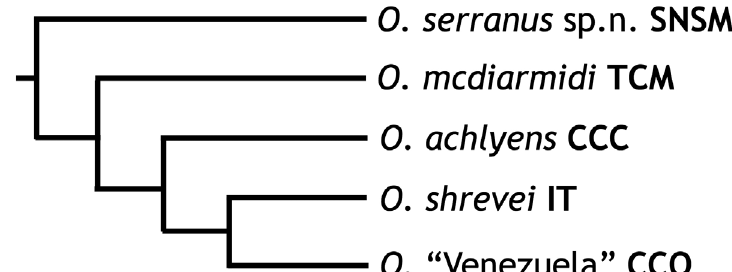
Figure 6. Summary of the phylogeny and geographic distribution of Oreosaurus (Sánchez-Pacheco et al. 2017). SNSM = Sierra Nevada de Santa Marta, Colombia; TCM = tepuis from the Chimantá massif, Venezuela; CCC = Cordillera de la Costa Central, Venezuela; IT = island of Trinidad; CCO = Cordillera de la Costa Oriental, Venezuela. Oreosaurus luctuosus , from the CCC, and O. rhodogaster , from the CCO, were included in this genus due to the presumed close relationships of these species and O. achlyens and O. shrevei , respectively. Data taken from Sánchez-Pacheco et al.